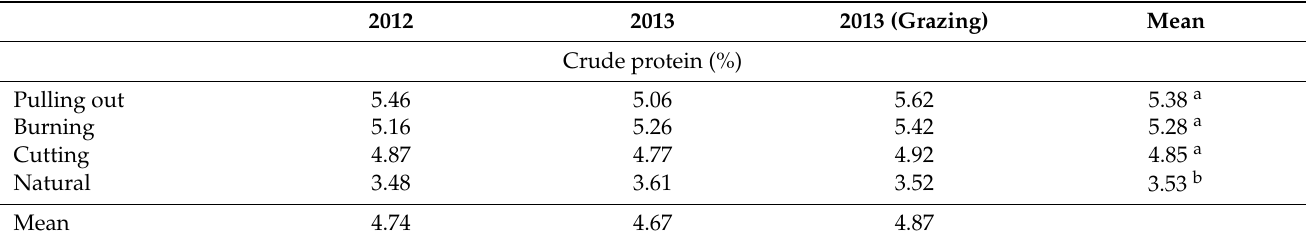
Table 4. Amount of CP, NDF, ADF and DDM of herbage harvested from improved and grazed